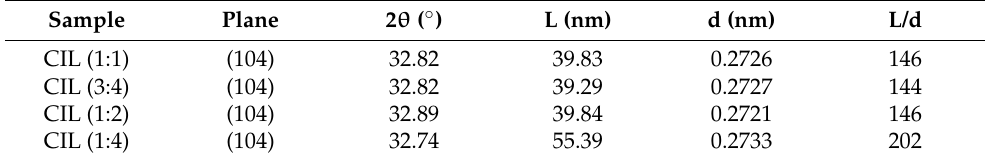
Figure 1. XRD patterns of the ( a ) raw materials and ( b ) fabricated nanocomposites. Table 1. Crystallographic parameters calculated from XRD data. Table 1. Crystallographic parameters calculated from XRD